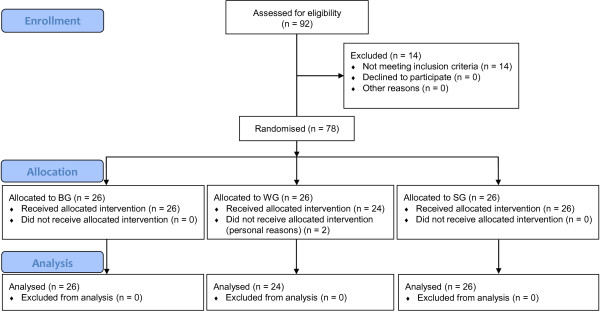
CONSORT flow diagram. BG, blue lupin group; WG, white lupin group; SG, soya group; blue lupin, Lupinus angustifolius cv. Boregine; white lupin, Lupinus albus cv. Typ Top; soya, Glycine max cv. Hefeng.